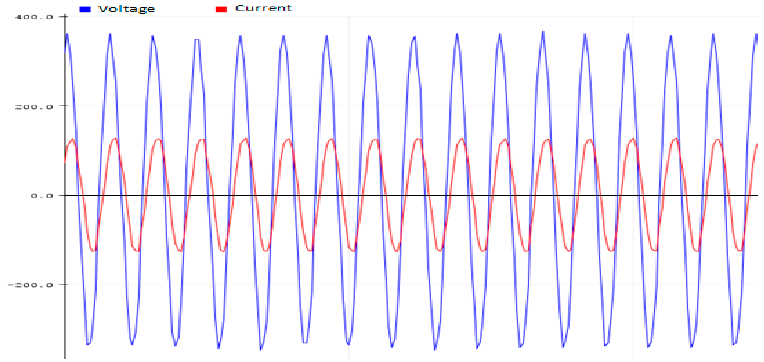
Figure 12. Waveform captured for electric iron box load.